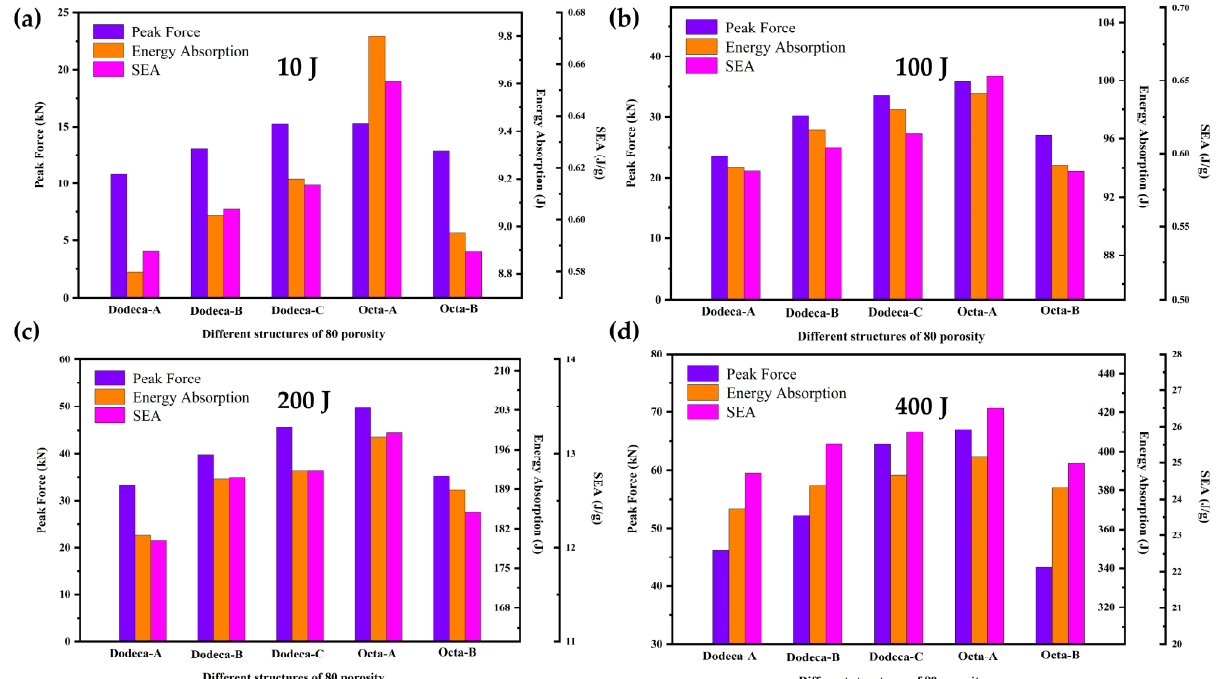
Figure 6. Comparison of energy-absorption indices of 80%-porosity structures under different impact energies: ( a ) 10, ( b ) 100, ( c ) 200 and ( d ) 400 J.